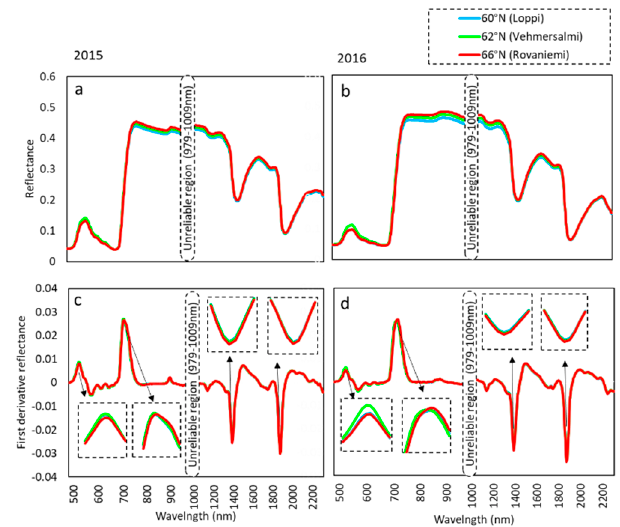
Figure 1. ( a ) Average reflectance spectra of 2015 and ( b ) 2016 ( c ) first derivative reflectance of 2015 and ( d ) 2016 of silver birch leaf for three provenances: Loppi (L, 60° N, southern Finland), Vehmersalmi (V, 62° N, central Finland), and Rovaniemi (R, 66° N, northern Finland). Average reflectance was calculated on leaf reflectance ( n = 39–41) replicates for provenance in 2015 and on leaf reflectance ( n = 36 × 3) replicates for provenance in 2016.